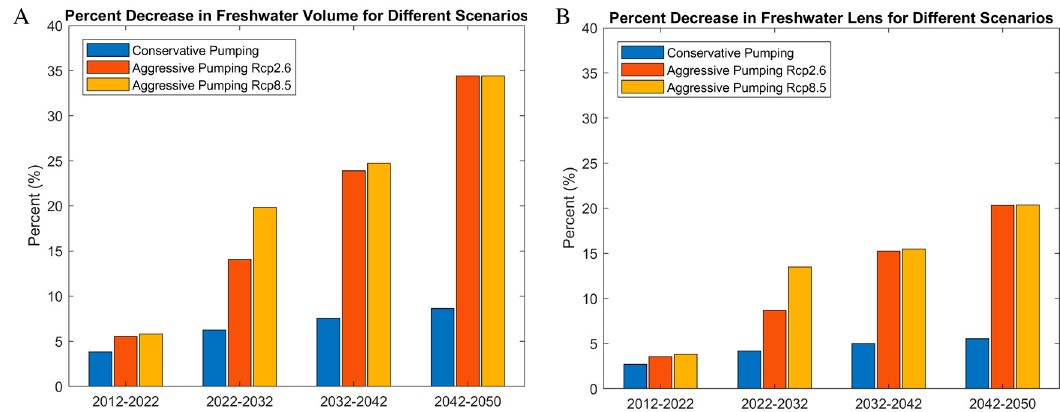
Figure 9. Percentage decrease in ( A ) freshwater lens volume and ( B ) freshwater lens thickness for each decade of simulation, as compared to the 2012 values for Scenarios 2 and 3 (conservative and aggressive pumping, respectively). These scenarios do not include the influence of future rainfall patterns. Scenario 3 includes both the RCP2.6 and RCP8.5 climate scenarios.